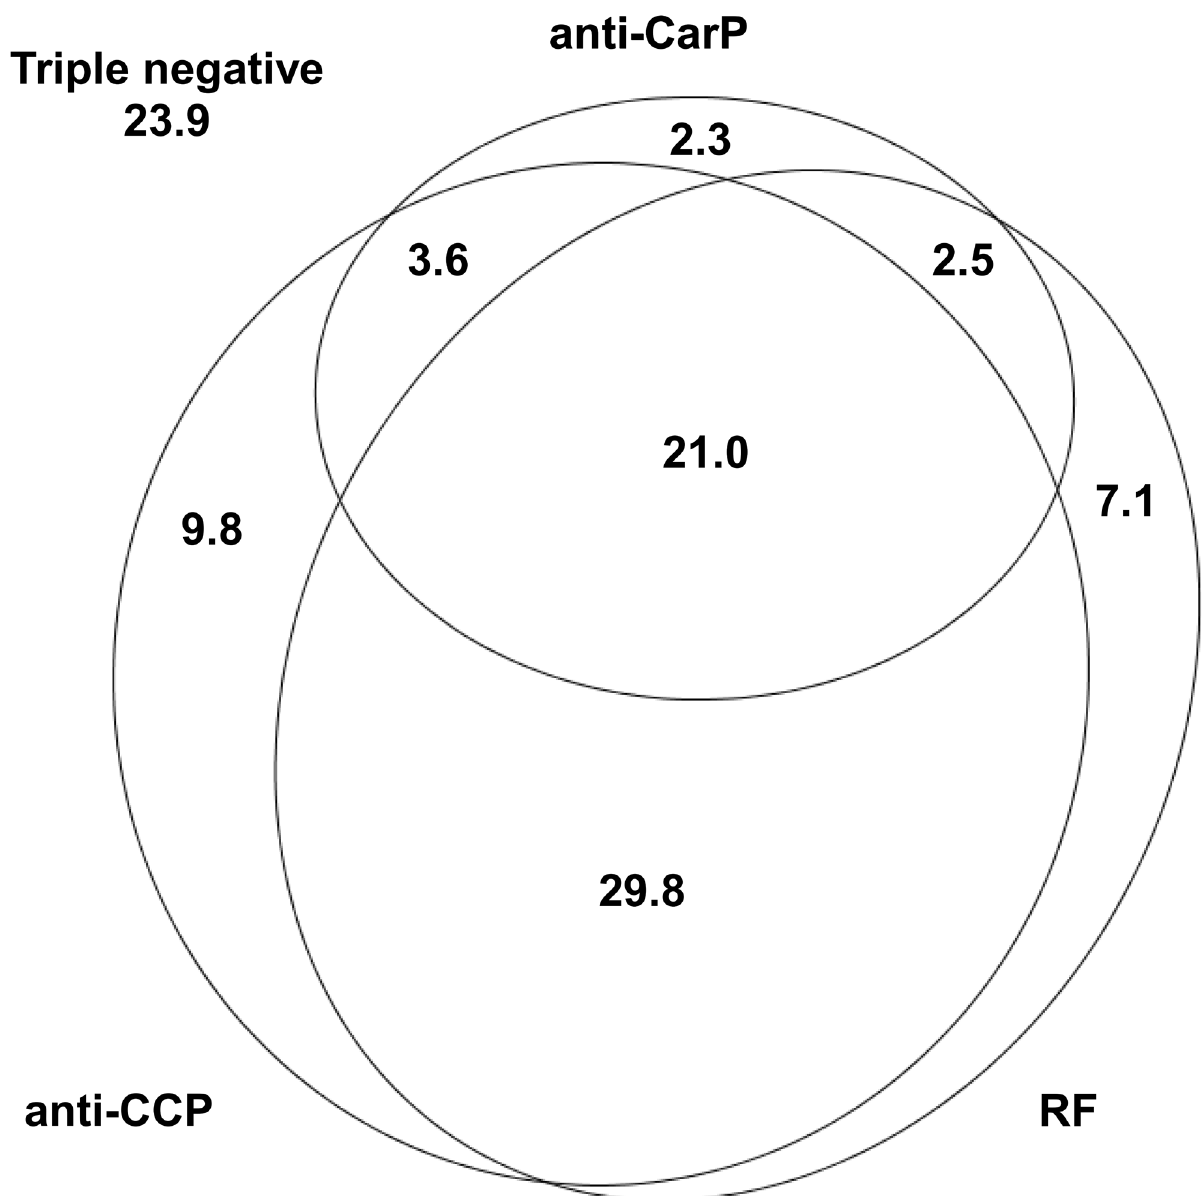
Fig 1. Distribution of patients with RA positive for the different autoantibodies. We observed that anti-CarP antibodies were not associated with the SE alleles (Fig 2A). This lack of association was found in all analyses performed, which included either all the SE alleles together (OR = 1.1, P = 0.6), or only the HLA-DRB1 * 01 alleles (OR = 0.9, P = 0.7), or the * 04 alleles (OR = 1.0, P = 0.9), or the * 1001 allele (OR = 1.2, P = 0.7). In addition, we did not observe association in analyses conditional on the anti-CCP status (OR = 0.8, P = 0.4), the RF status (OR = 0.9, P = 0.6) or both (OR = 0.8, P = 0.3). In a similar way, there was no association of the anti-CarP status with the PTPN22 R620W polymorphism (Fig 2B). Again, this result was consistent in the direct analysis (OR = 0.9, P = 0.7), and in the conditional on other autoantibodies (OR = 0.8, P = 0.5 conditional on anti-CCP; OR = 1.0, P = 0.8 conditional on RF; and OR = 0.9, P = 0.7 conditional in the two other autoantibodies). Finally, we did not observe association of the anti-CarP antibodies with smoking (OR = 1.0, P = 0.9; Fig 2C). We should note that the anti-CCP positive status was associated with the SE alleles (P = 2.4 x 10 − 7 ), showed a stronger association than the anti-CCP negative status with the PTPN22 R620W polymorphism (P = 0.002 for anti-CCP positive and P = 0.13 for anti-CCP negative patients), but it was not associated with smoking (P = 0.65) in our patients, as we already have noted previously [16,17]. All these analyses were adjusted for gender, age at disease onset and time of